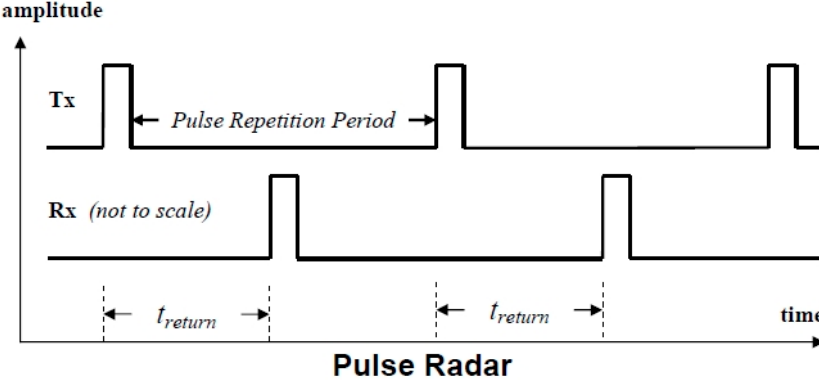
Figure 24. Pulse radar measurement principle.